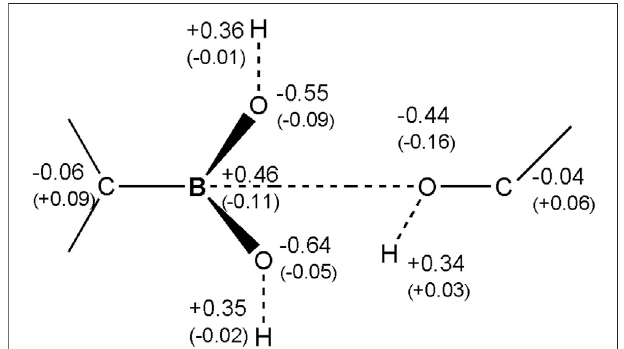
FIGURE8| AtomicMullikenchargesontheboronmolecularfragmentof the 3-NPBA inhibitor, as well as on the hydroxyl group of Ser 70. The charges were computed for the initial state, before the formation of the chemical -B-O- bond. In parentheses are changes of the charges for the fi nal state, after the formation of the chemical